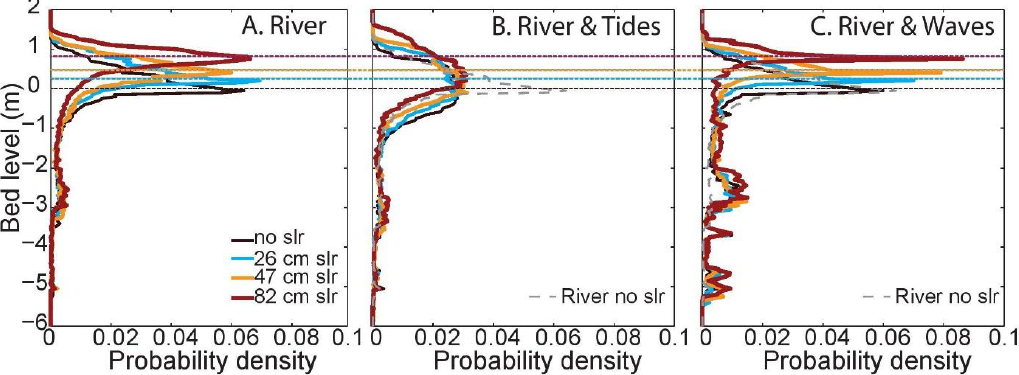
Figure 2. Delta bed level (m) as a function of sea-level rise scenario and coastal forcing. ( A ) River-dominated coasts. ( B ) River- and tidally-influenced coasts. ( C ) River- and wave-influenced coasts. Projected sea levels in 2100 indicated by horizontal lines.